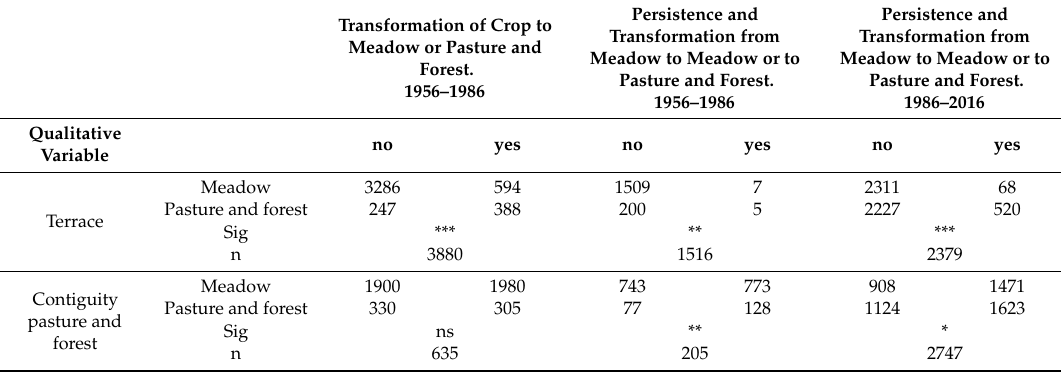
Table 4. Characteristics and comparison of the number of the parcels (n) that have been transformed or not into a meadow or pasture and forest in the di ff erent scenarios. Qualitative